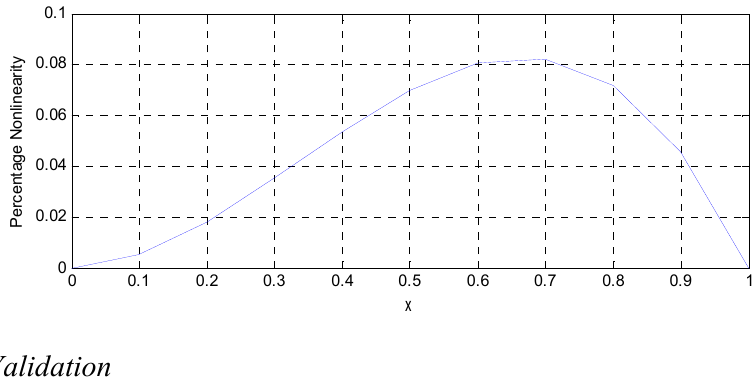
Figure 6. Analysis of nonlinearity in displacement to voltage